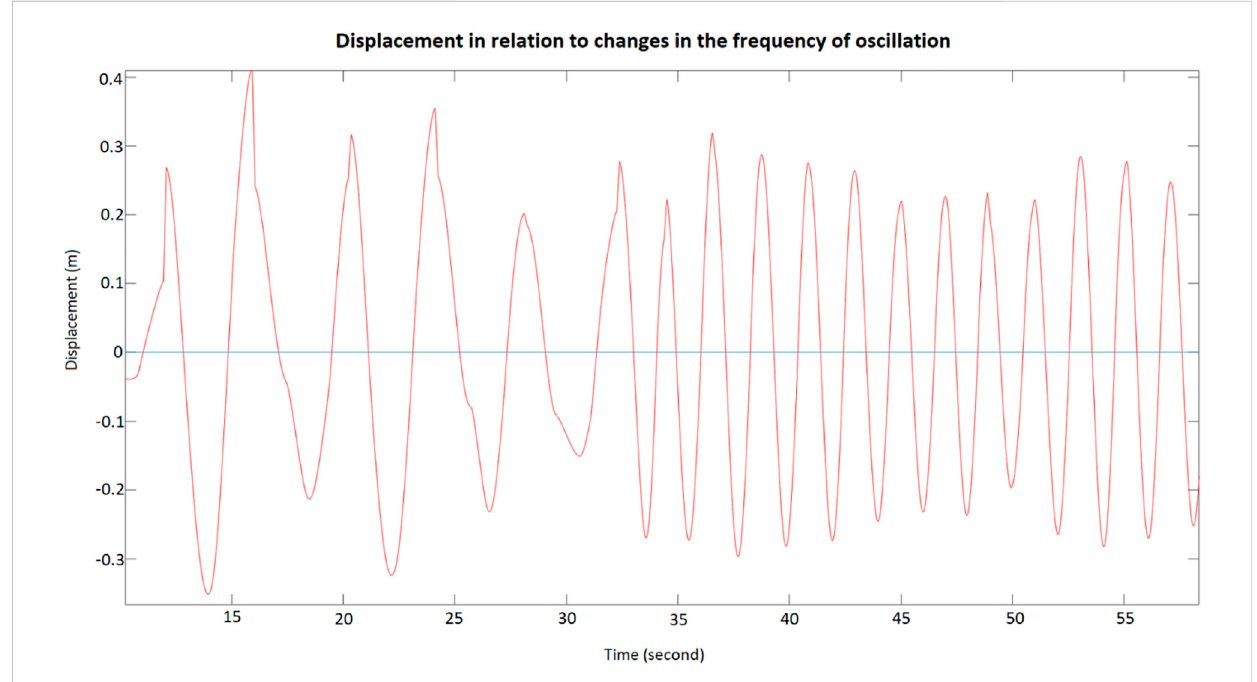
FIGURE 6 Changes in the frequency of oscillation.